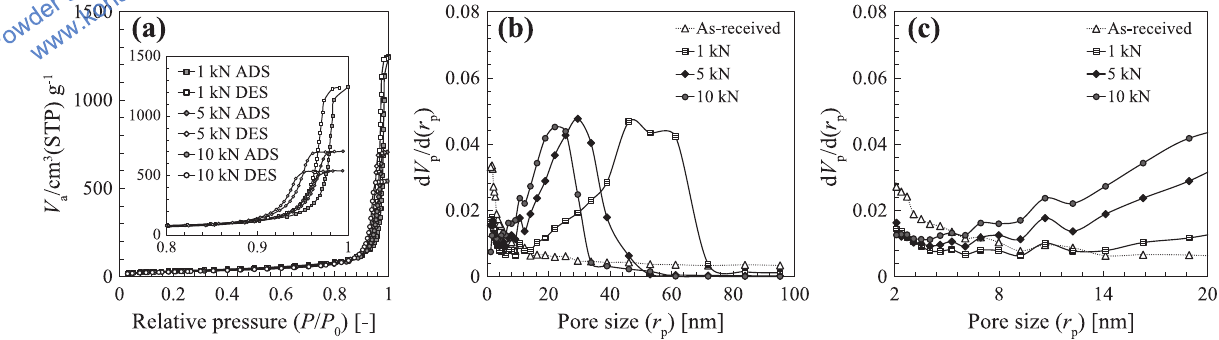
Fig. 8 (a) Nitrogen gas adsorption (ADS) and desorption (DES) isotherm and (b) BJH pore size distributions ( (c) enlarged) of model